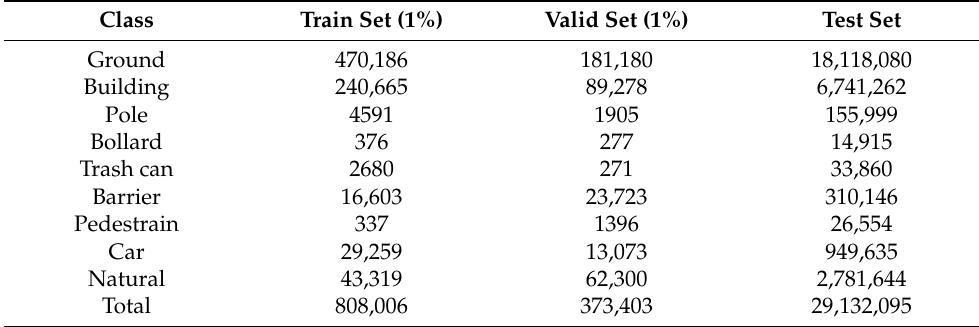
Table 1. NPM3D dataset category distribution table. The training and validation dataset are a 1% random sample.